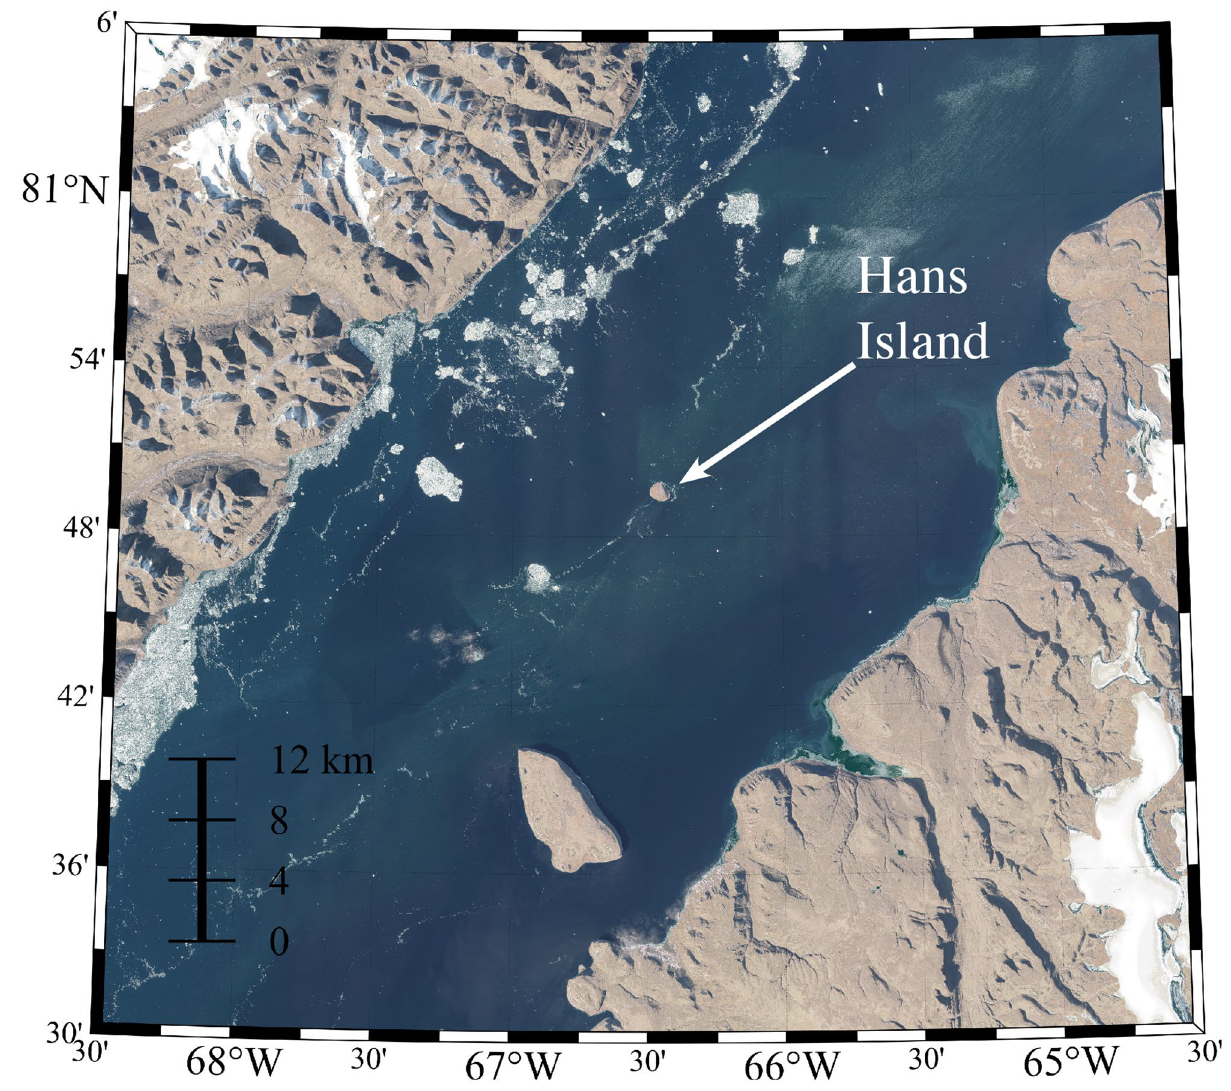
Figure 2. True-color high spatial resolution (~ 10 m) Sentinel-2 imagery of the Kennedy Channel in the vicinity of Hans Island on August 7 19:39 GMT 2020. Figure created using Matlab R2019b (https:// www. mathw orks.